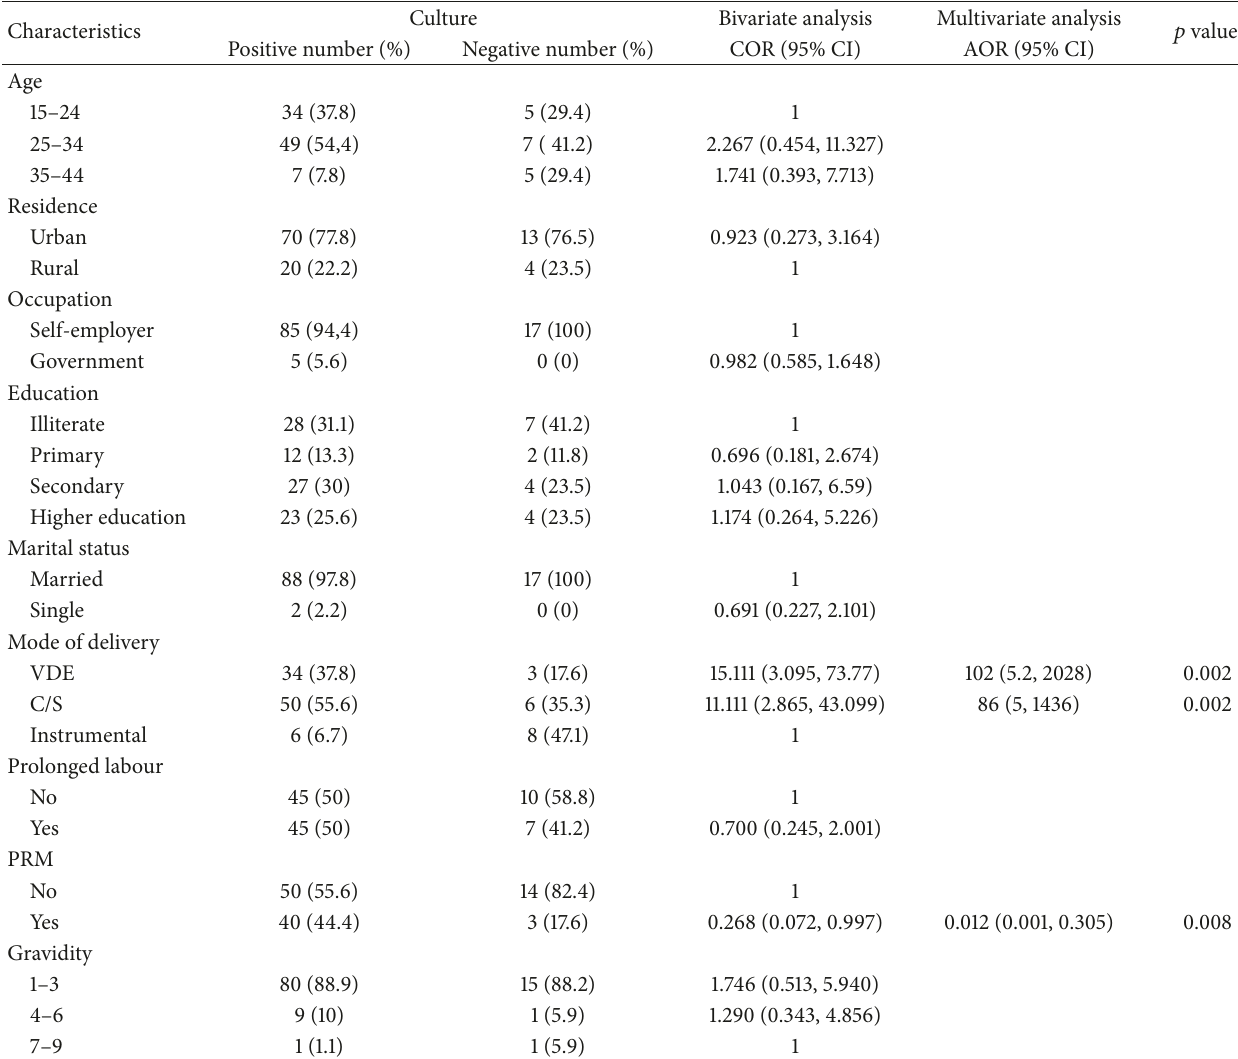
Table 5: Bivariate and multivariate analysis for the assessment of factors associated with bacterial infection from women attending antenatal and postnatal service at the University of Gondar Teaching Hospital from 1 January 2016 to 30 May